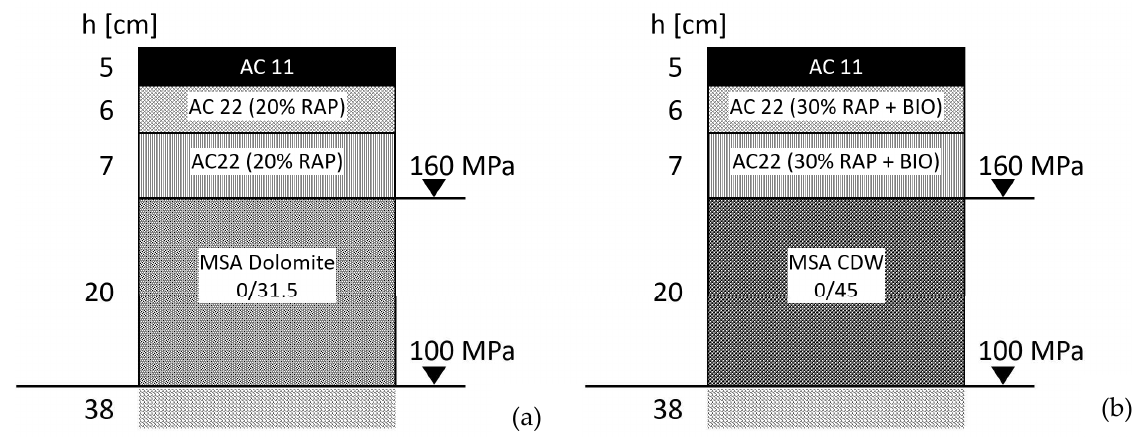
Figure 1. Structure of trial sections: ( a ) reference section and ( b ) APSE experimental section.